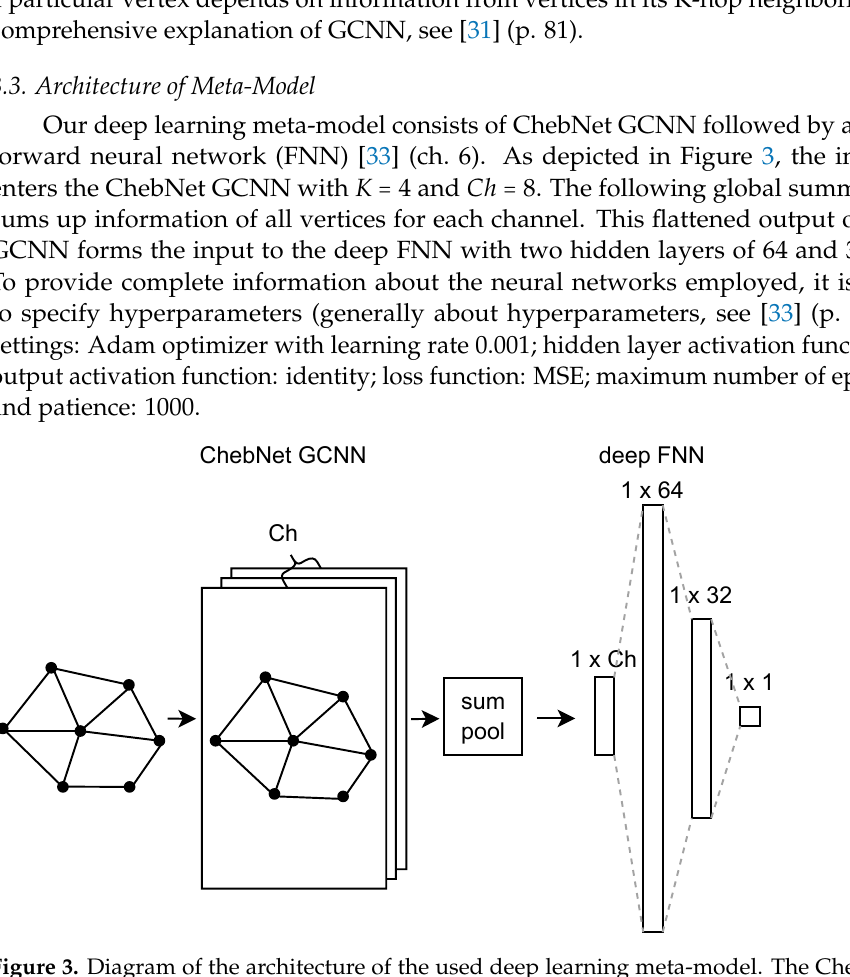
Figure 3. Diagram of the architecture of the used deep learning meta-model. The ChebNet graph convolutional neural network is followed by the global summation pool and the deep feed-forward neural network with hidden layers of 64 and 32 neurons. The convolutional kernel has Ch